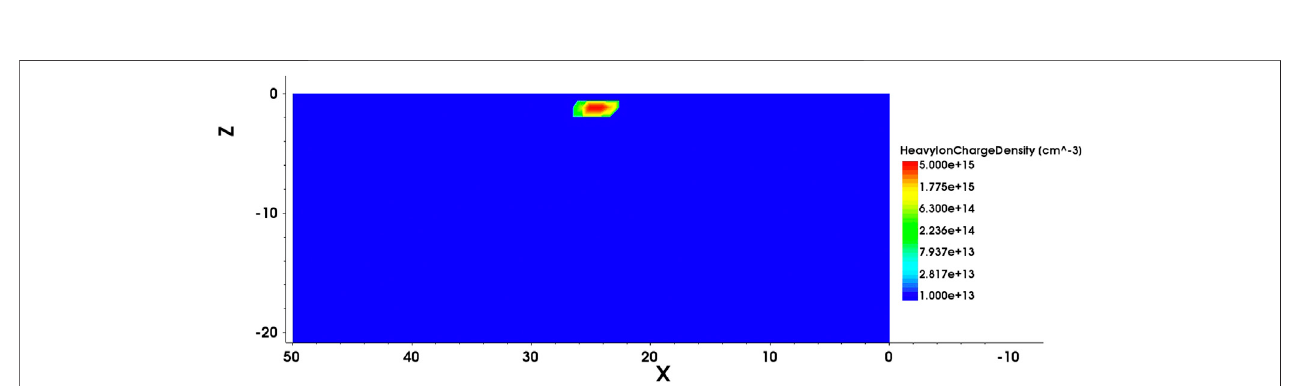
FIGURE 10 | Illustration of photon absorption simulation, showing charge cloud initiated 1 mm (1000 μ m) from the entrance window surface.